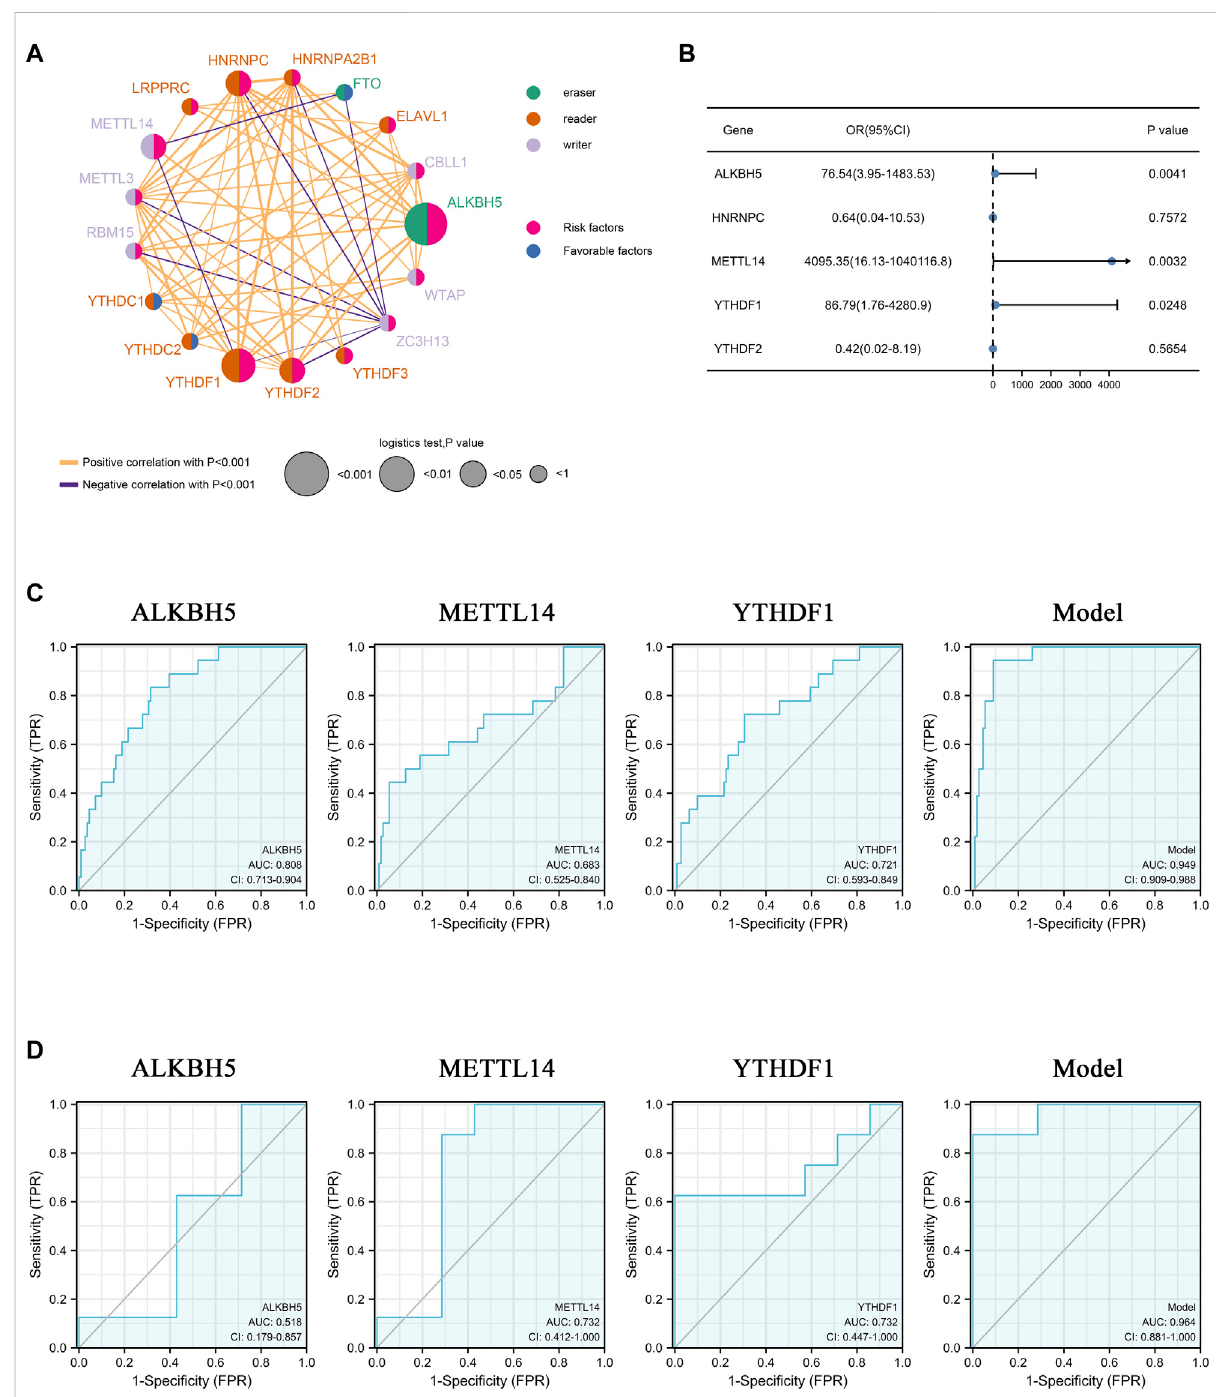
FIGURE 2 Clinical features of 17 m6A methylation regulators. (A) The interaction network among m6A methylation genes. The circle size represents the effectonthepredictionandscaleby p -value. Riskfactors:pink;Favorablefactors:blue;Erasers:green;Readers:orange;Writers:purple.The orange and purple lines represent positive and negative correlations, respectively ( p < 0.001). (B) Forest plot of multiple logistic regression of 5 m6A methylation regulators. Blue dots represent the odd ratio of each regulator. (C,D) ROC curveof m6A regulatorsin predicting theoccurrence of AAA. (C) : training set, (D) validation set. AUC: area under the curve. CI: 95% con fi dence